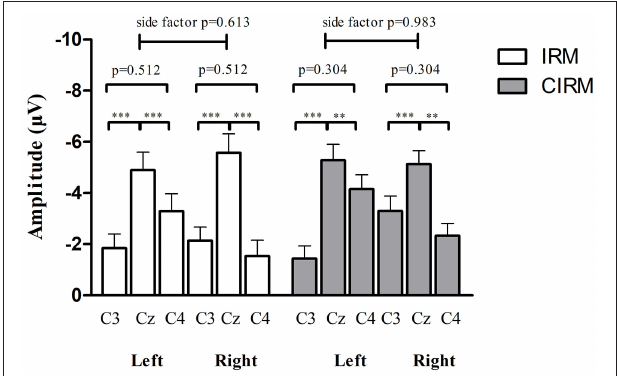
FIGURE 4 | MP amplitude at C3, Cz, and C4 location in IRM and CIRM. There were significant differences between Cz and C3 and between Cz and C4 ( p < 0.01), but not between C3 and C4 in both tests. Negative upwards. ** p < 0.01, *** p <